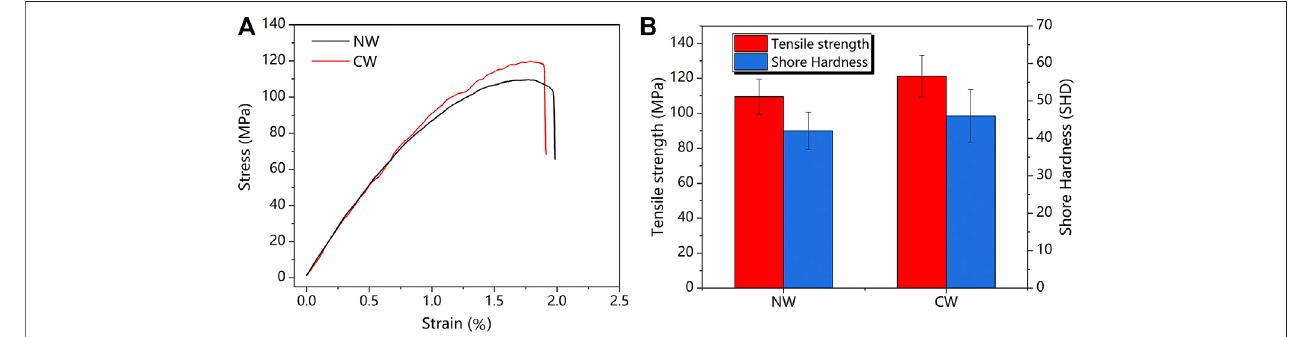
FIGURE 8 | Comparison of mechanical properties of NW and CW. (A) Representative stress-strain curves of NW and CW. (B) The tensile strength and shore hardness of NW and CW.